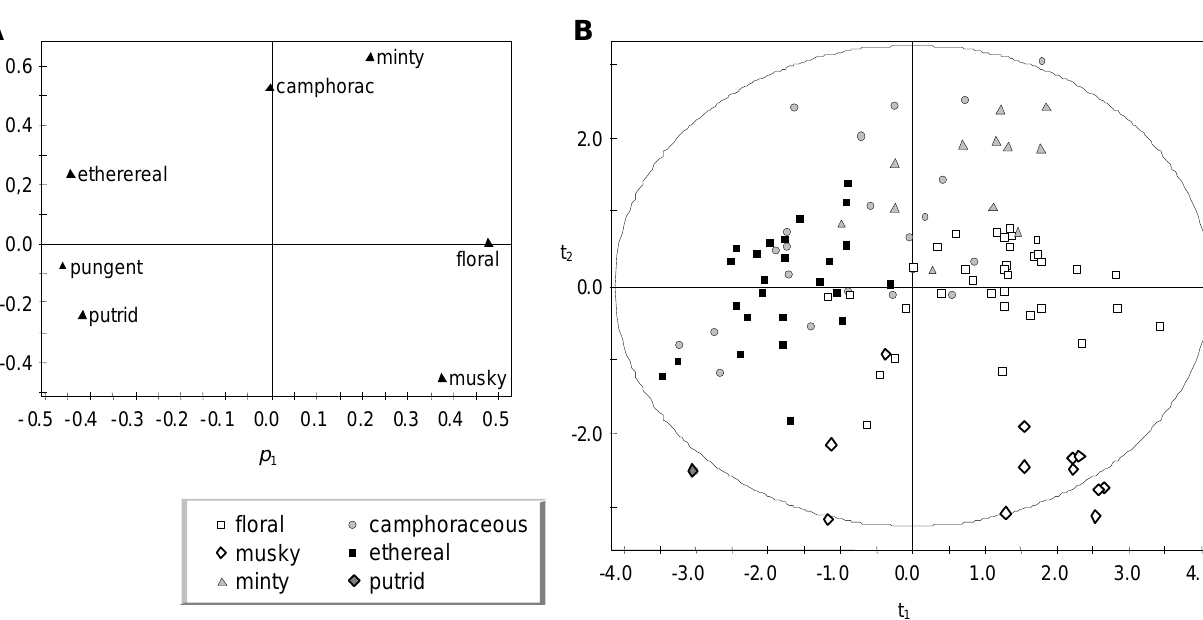
vs. p ) and (B) score plot 2 1